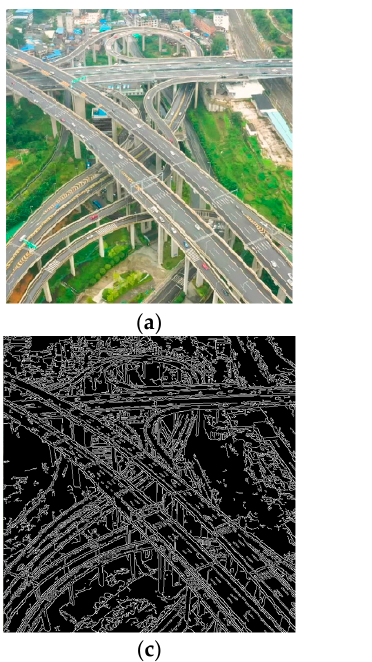
Figure 10. The effect picture of the image after bilateral filtering. ( a ) Original image of overpass; ( b ) image after bilateral filtering; ( c ) Canny edge detection on the original image; ( d ) Canny edge detection after bilateral